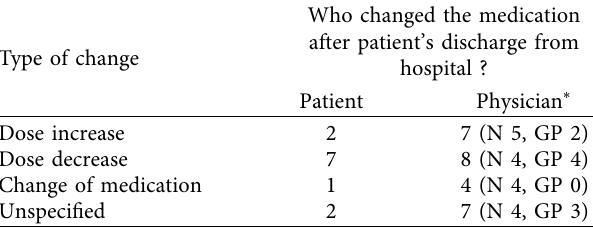
Table 2: Type of medication change and the initiator of change (the number of